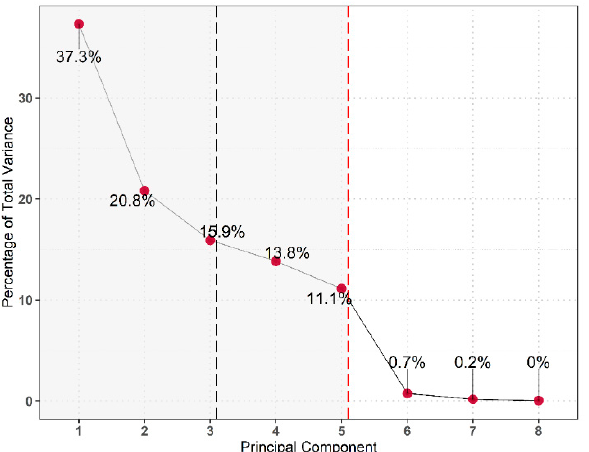
Figure 15. Scree plot of principal components and their share of explained sample variance. The shaded region behind the black and red line represents the total variance of 74% and c.a. 99%, captured by PC1 to PC3 and PC1 to PC5, respectively.